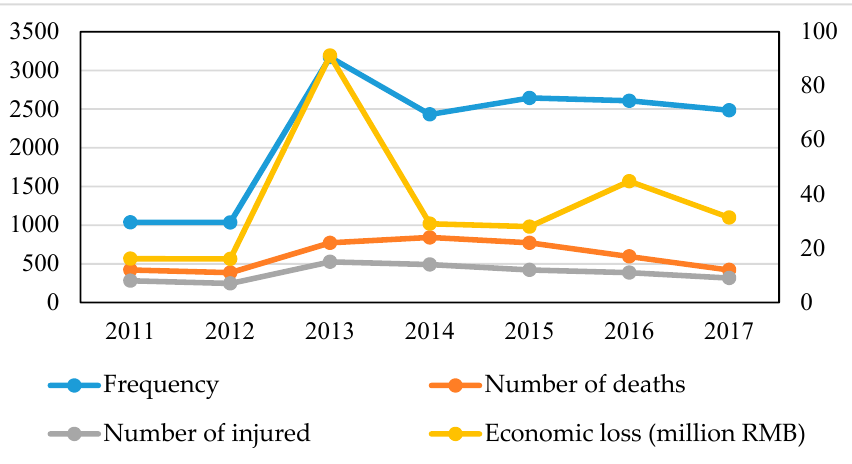
Figure 6. Fire statistics in Guangzhou from 2011 to 2017.